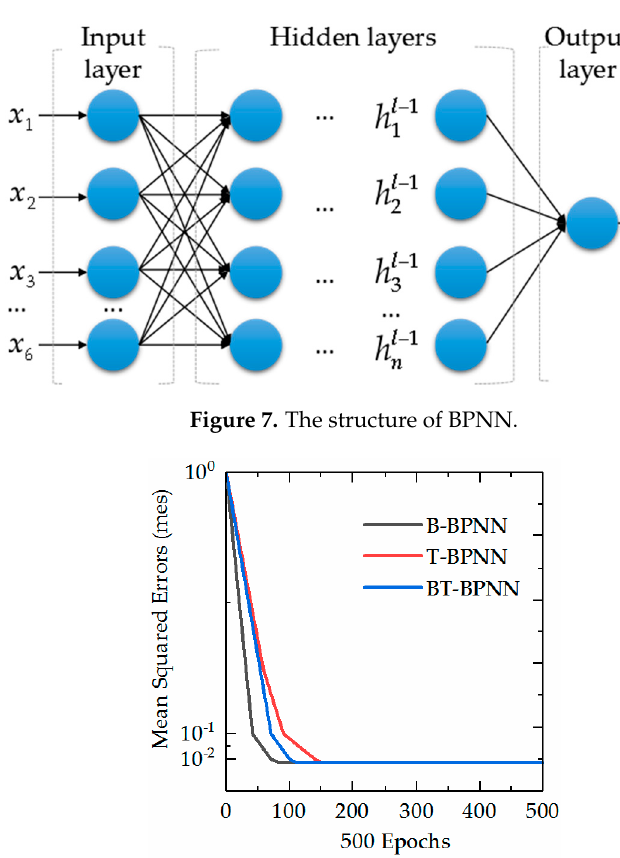
Figure 8. Iterative results of three BPNNs.